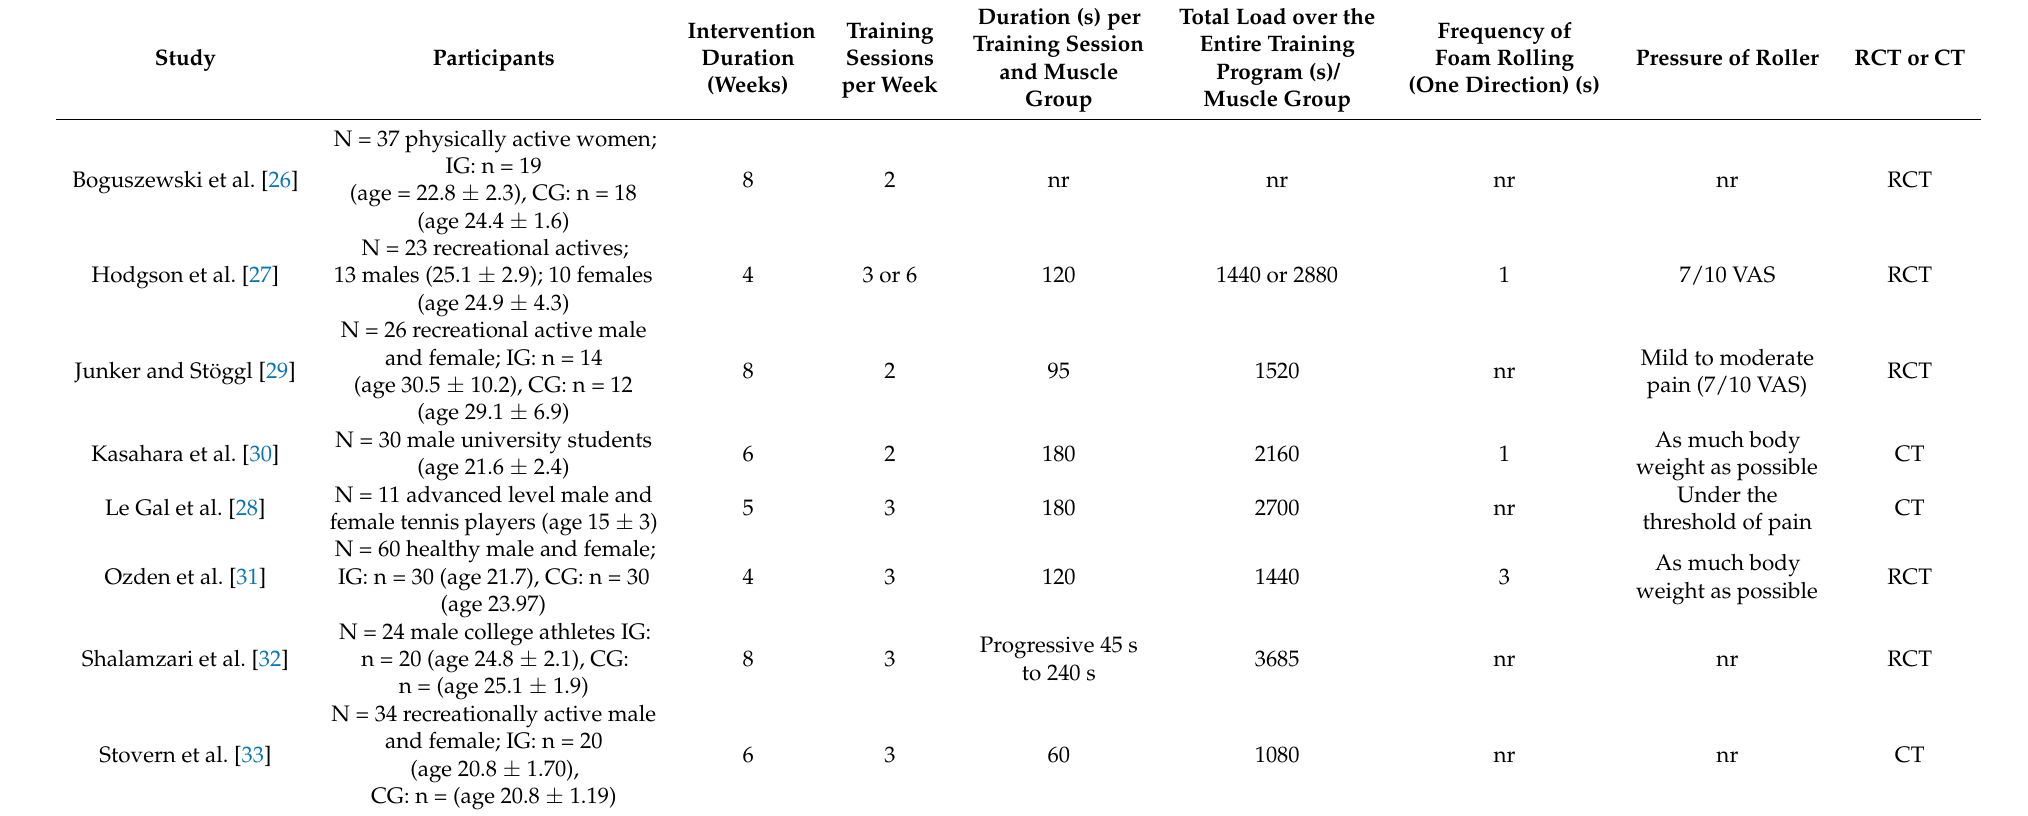
Table 1. Characteristics of the included studies (n = 8). IG = intervention group; CG = control group; nr = not reported; VAS = visual analogue scale; ROM = range of motion; bl = bilateral; RCT = randomized controlled trial; CT = controlled